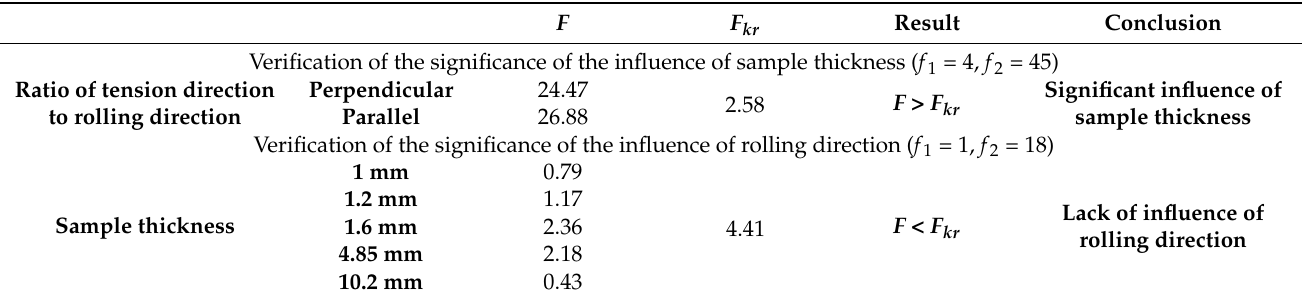
Table 8. The results of the analysis of the significance of the influence of the studied variables on ultimate tensile strength UTS R m . F F kr Result Conclusion Verification of the significance of the influence of sample thickness ( f 1 = 4, f 2 = 45) Ratio of tension direction Perpendicular to rolling direction